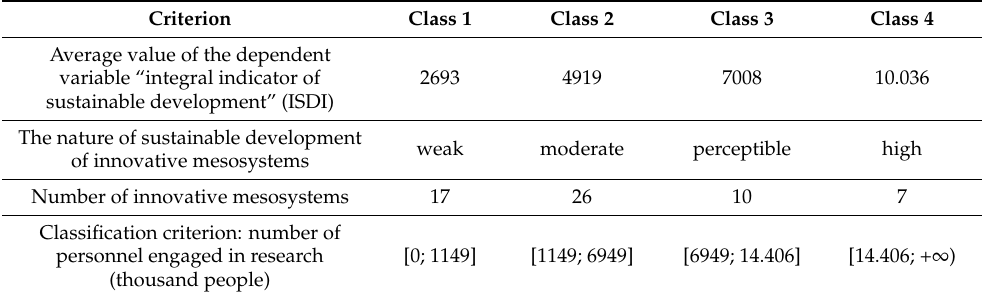
Figure 5. Algorithm for differentiated identification of priority areas for sustainable development of innovative mesosystems in industry. Table 2. Typology of innovative mesosystems based on a regression